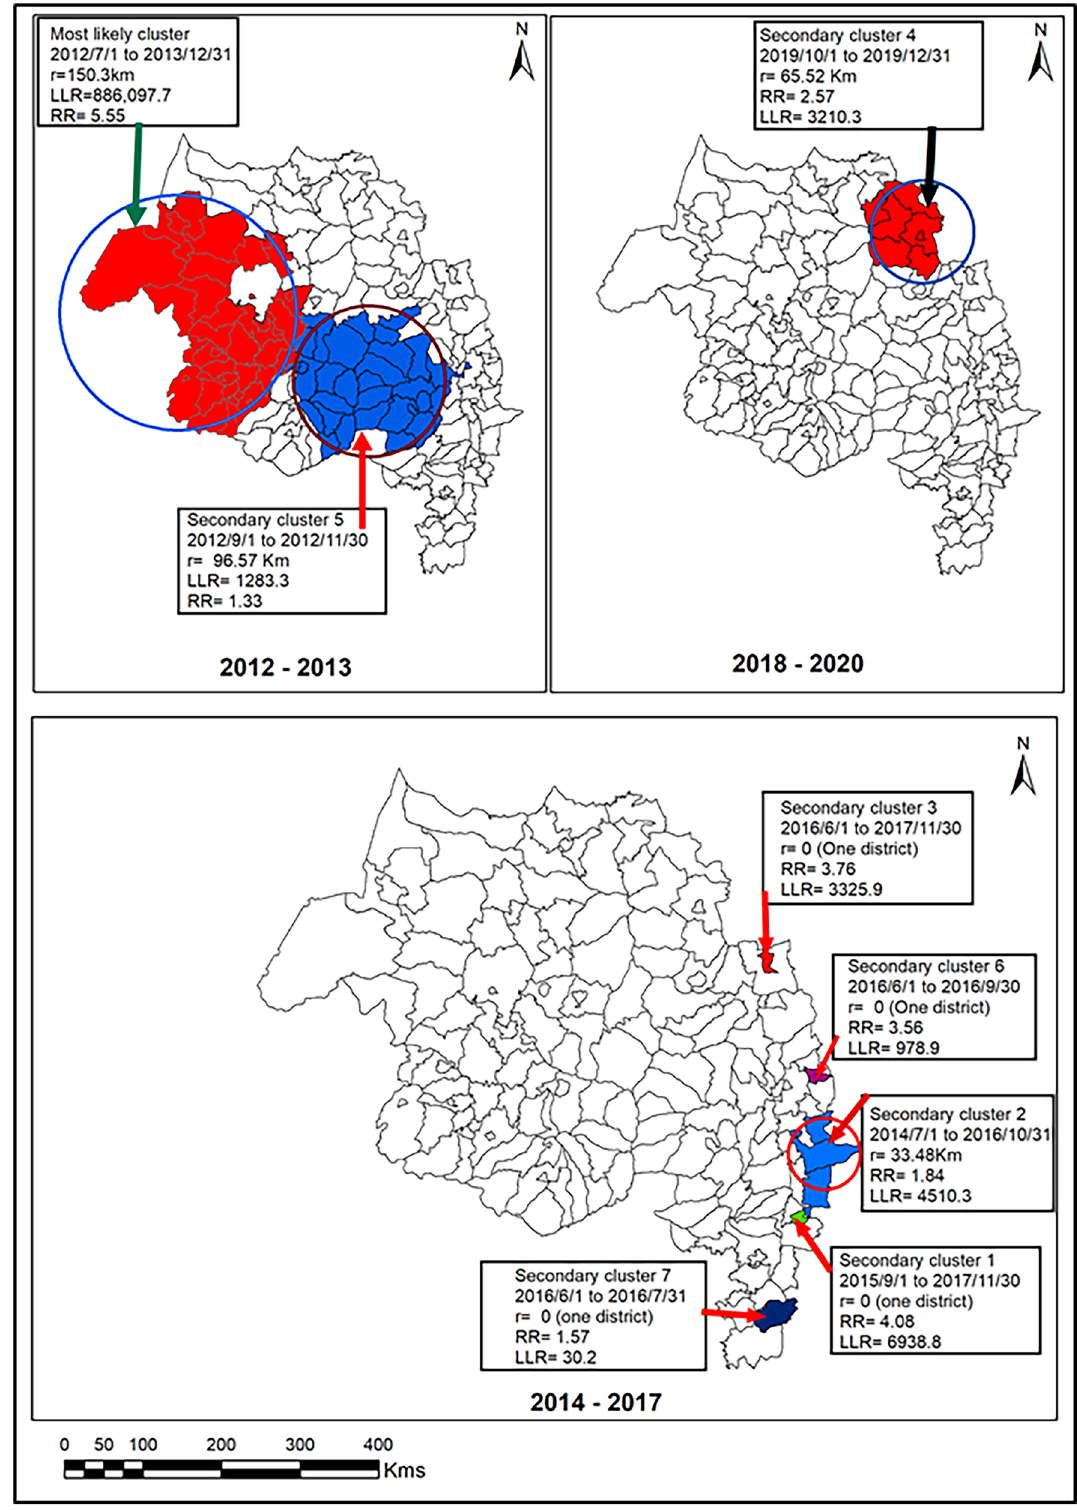
Figure 5. Space–time detection of clusters of malaria cases in the Altitude and LLINS adjustment covariate in northwest Ethiopia,